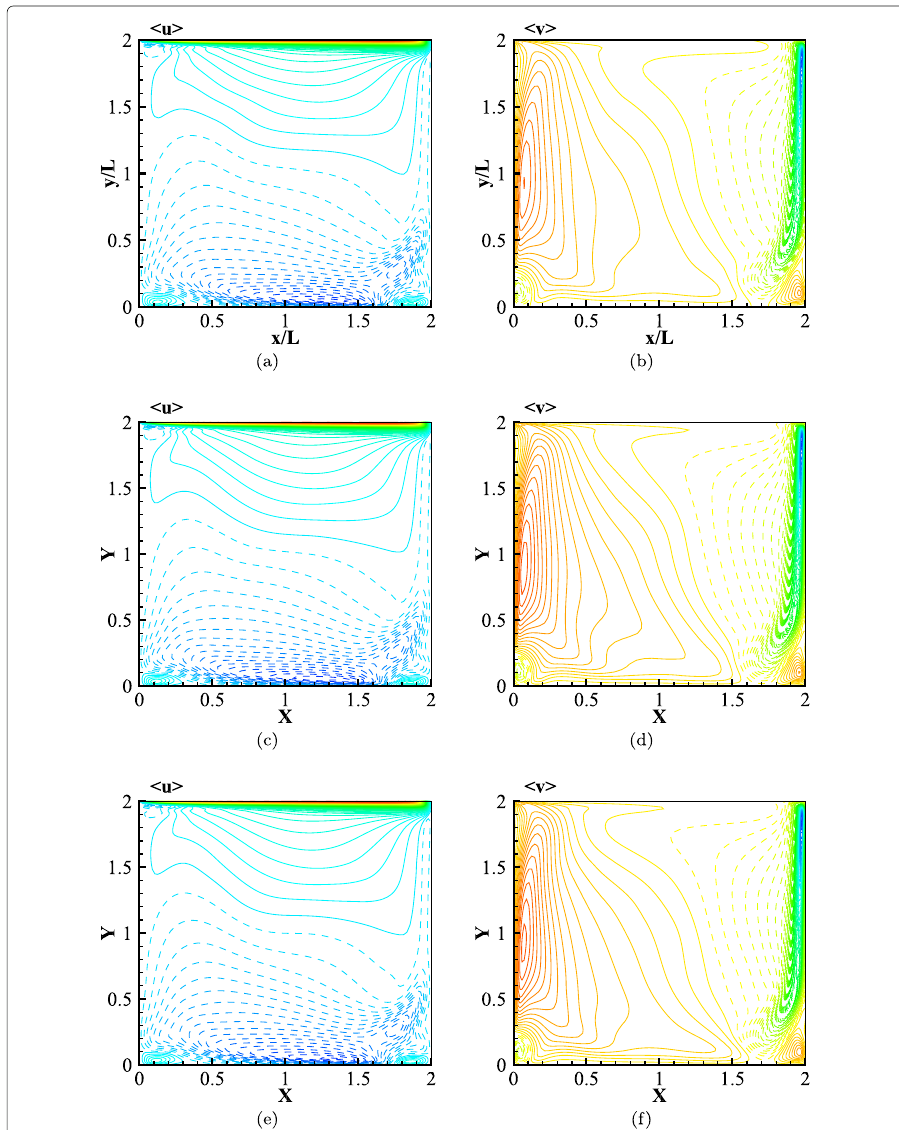
Fig. 17 Contours of average velocity in the mid-plane Z = 1. 100 contours levels taken between − 0.25 and 0.86 for (cid:12) u (cid:13) and between − 0.58 and 0.17 for (cid:12) v (cid:13) . Dashed contours lines correspond to negative levels. a No SGS model (cid:12) u (cid:13) ; b No SGS model (cid:12) v (cid:13) ; c Vreman model (cid:12) u (cid:13) ; d Vreman model (cid:12) v (cid:13) ; e WALE model (cid:12) u (cid:13) ; f WALE model (cid:12) v (cid:13)